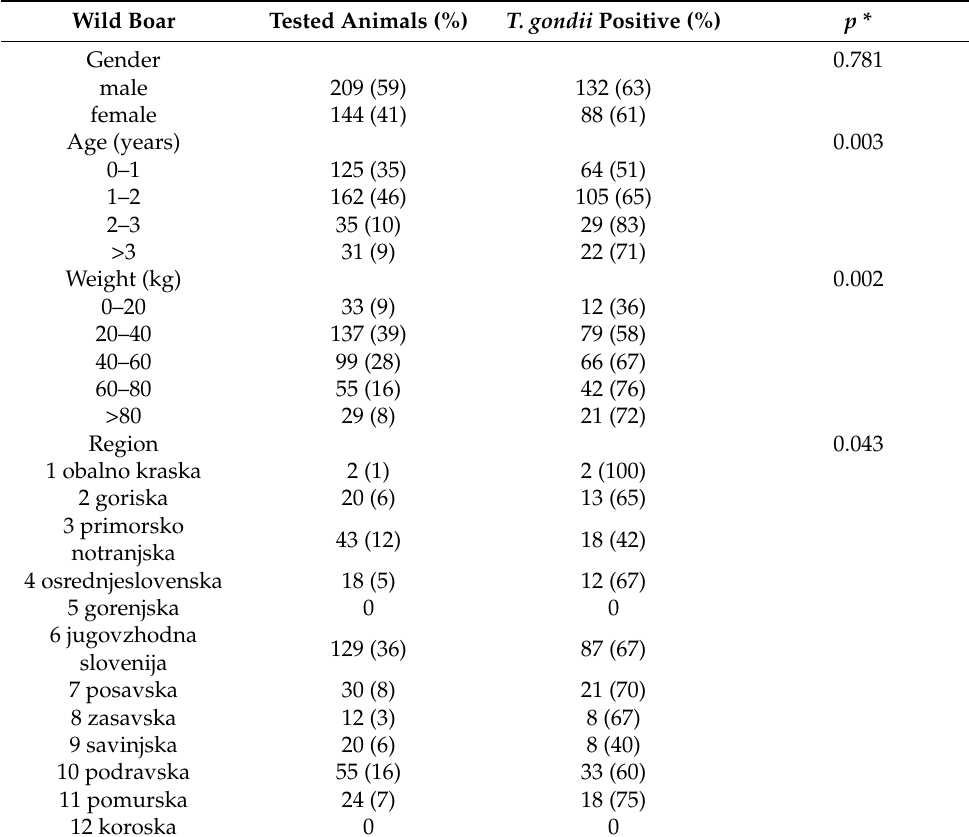
Table 1. Seroprevalence of T. gondii in wild boar based on sex, age, weight, and region. Wild Boar Tested Animals (%) T. gondii Positive